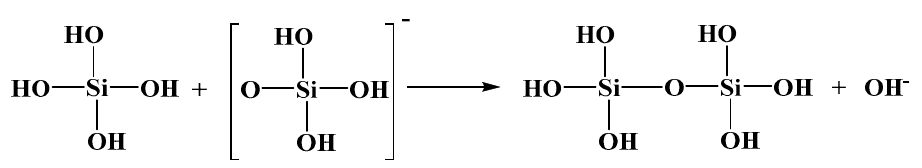
Figure 5. Speciation distribution of silicate anions as a function of the pH ( C = 1 × 10 − 4 mol/L). The sodium silicate species in aqueous solution may polymerize into polysilicic acid at a certain concentration [30,31]. In acidic solution, Si(OH) 4 may combine with H + to form H 5 SiO 4+ . In neutral or alkaline solution, Si(OH) 4 may lose H + to form H 3 SiO 4 − , favoring the polymerization reaction between Si(OH) 4 and H 3 SiO 4 − according to Figure 6 [31]: